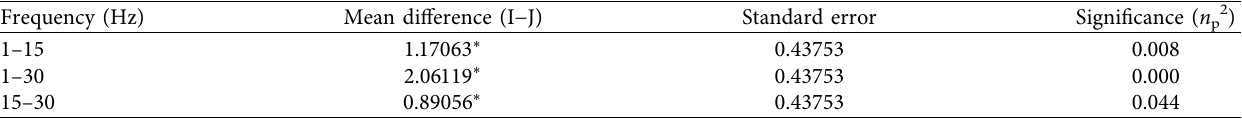
Table 4: Standard error and significance of reaction time between two different frequencies.